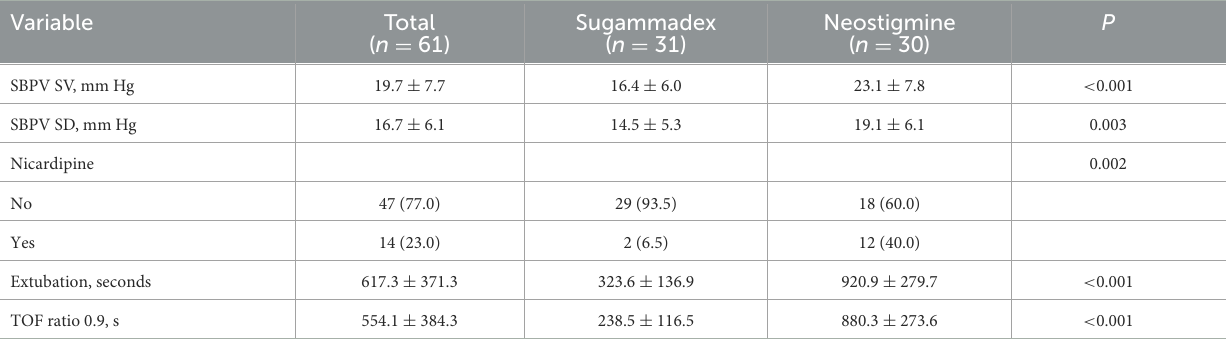
TABLE 3 The secondary outcome of patients in the sugammadex and neostigmine